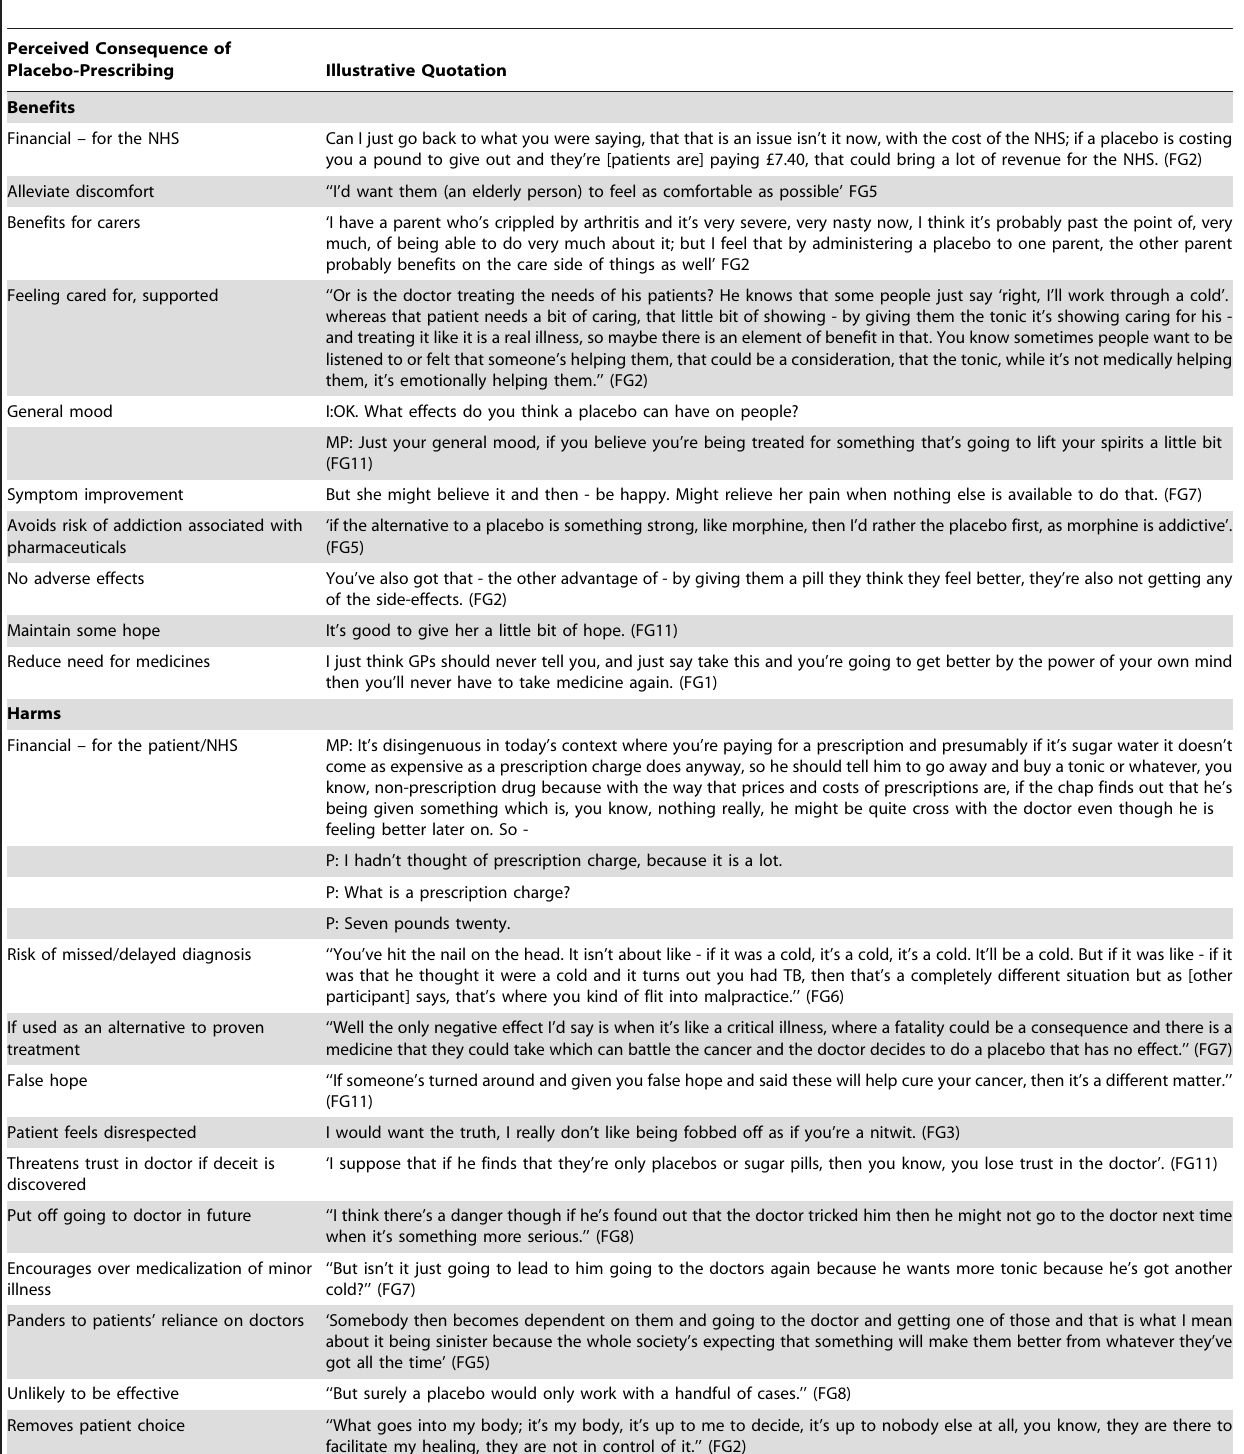
Table 2. Benefits and Harms of Placebo-Prescribing as Discussed in Focus Groups.